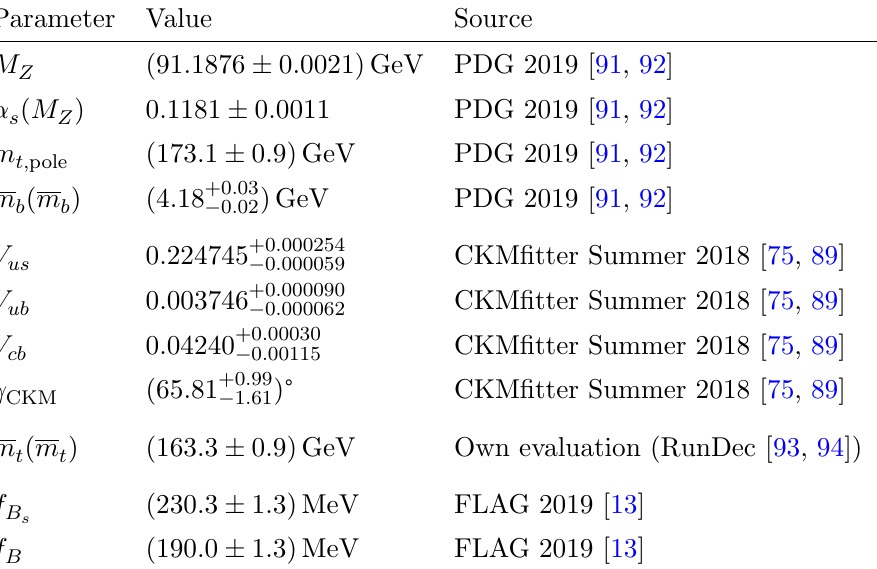
Table 2 . Input parameters for our calculations of (cid:1) M